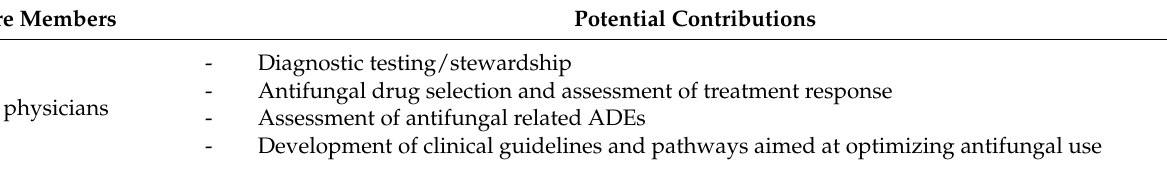
Table 2. Core members of an Antifungal Stewardship